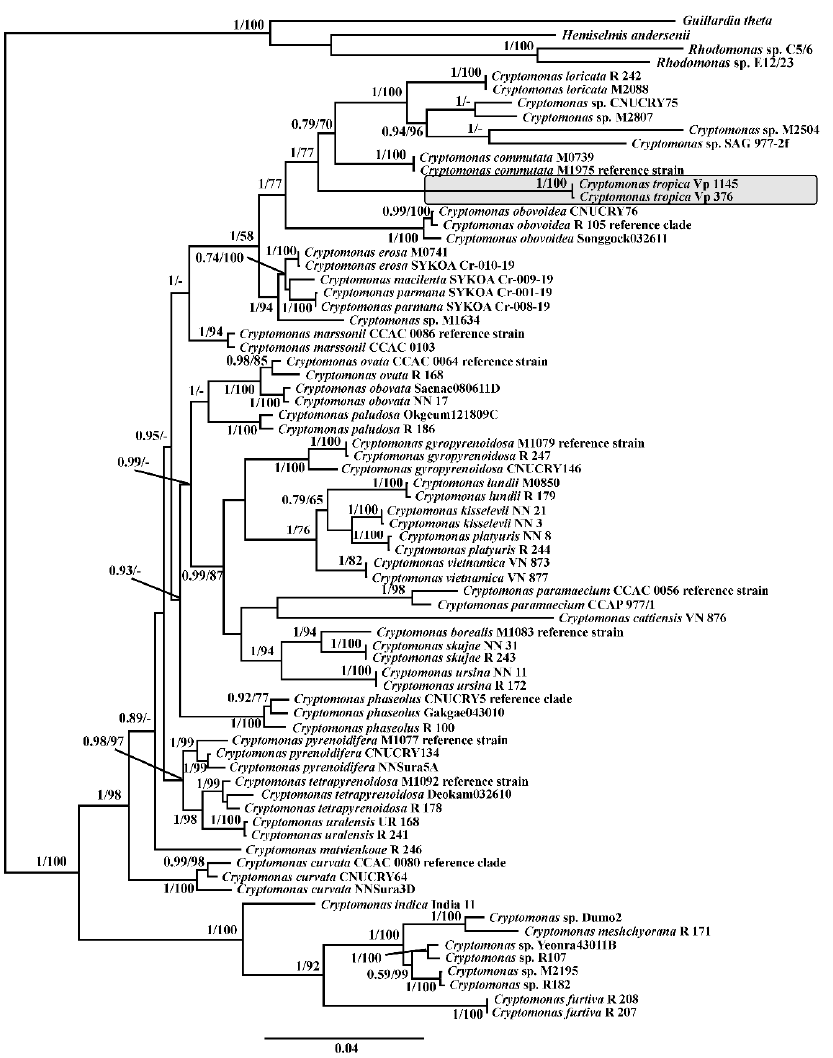
Figure 3. Molecular phylogeny of the genus Cryptomonas , based on combined data set of the partial nuclear SSU rDNA, LSU rDNA and chloroplast psb A genetic regions. Bayesian Posterior Probabilities and Maximum Likelihood bootstrap support are shown left and right of the fraction line, respectively. Scale bar represents substitutions per site. New described species are marked with a grey box.